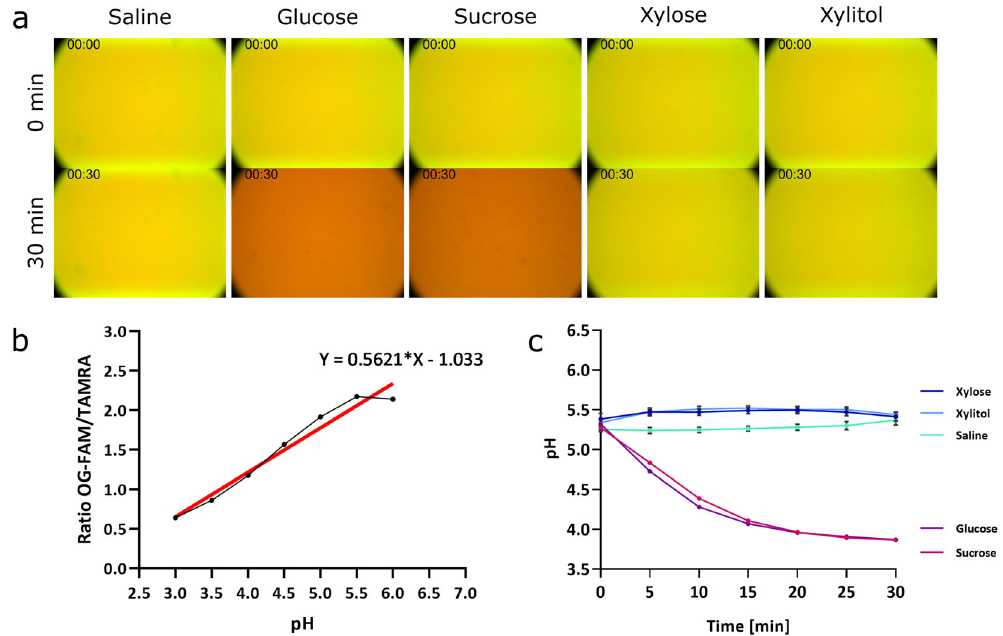
Fig. 6 Fermentation of glucose and sucrose, but not xylose, xylitol, or saline by S. mutans visualised with pH-sensitive nanosensors. Positively charged pH-sensitive nanosensors at a concentration of 1 mg mL − 1 were added to planktonic S. mutans NCTC 10449 grown overnight and normalised to an OD 600 of 1. Time-lapse images were taken with a Nikon wide fi eld microscope. a Representative fl uorescence images of cells with nanosensors in saline before the addition of either saline, glucose, sucrose, xylose or xylitol (top panel) to a fi nal concentration of 1% or after 30 min (bottom panel). An overlay image of the fl uorescence channels for green (OG-FAM) and red (TAMRA) is shown. b pH calibration of the nanosensors using the ratio between OG-FAM and TAMRA calculated from the fl uorescence intensities. Linear regression was calculated and used for pH determination of samples. c The pH of each condition at the indicated timepoints was calculated and plotted against the time of addition. Error bars represent standard error measured for different images, where n =